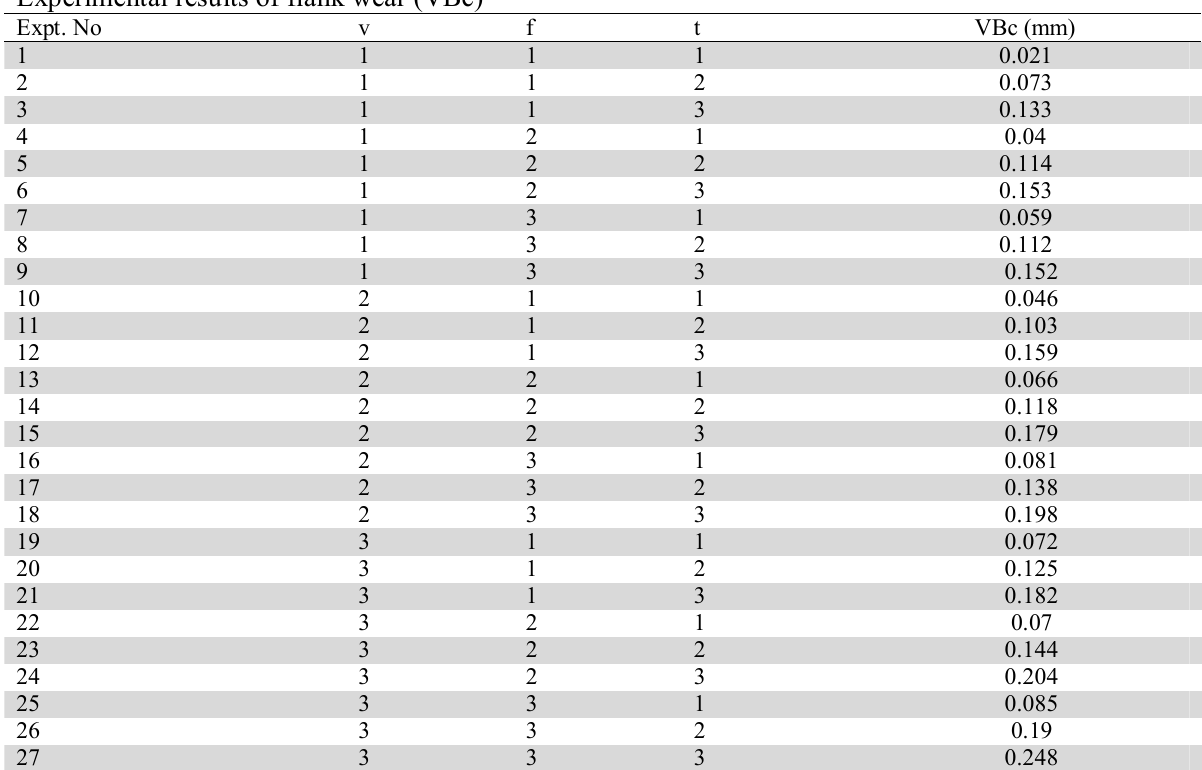
Experimental results of flank wear